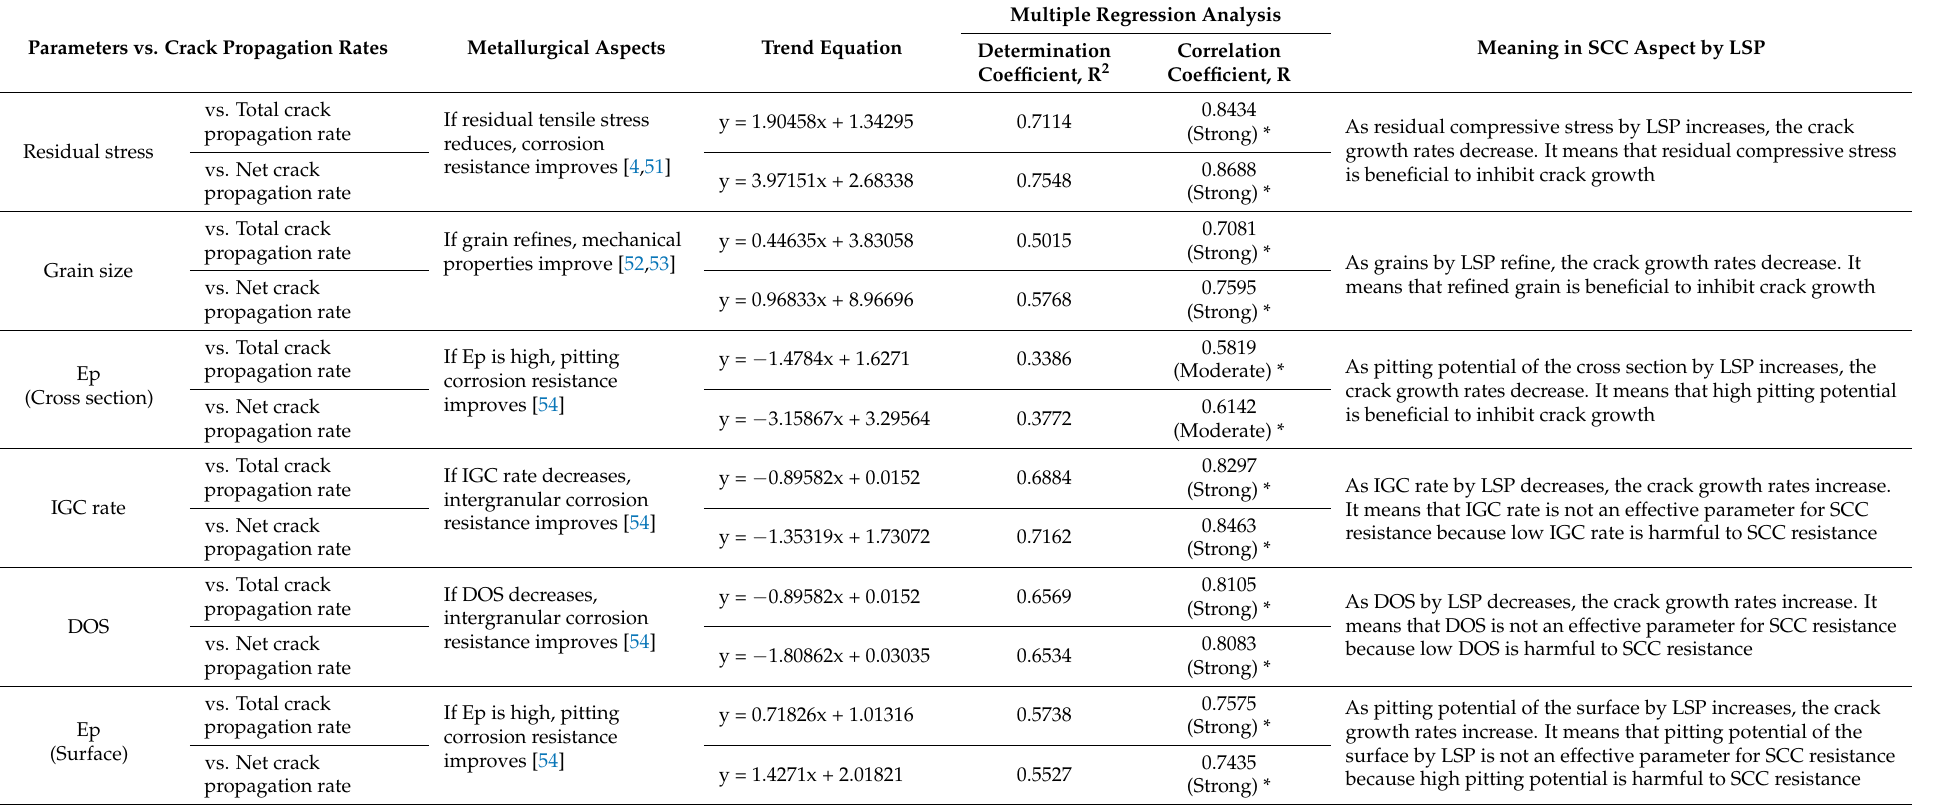
Table 8. Correlation between crack propagation rates and several important parameters and their meanings from metallurgical and SCC